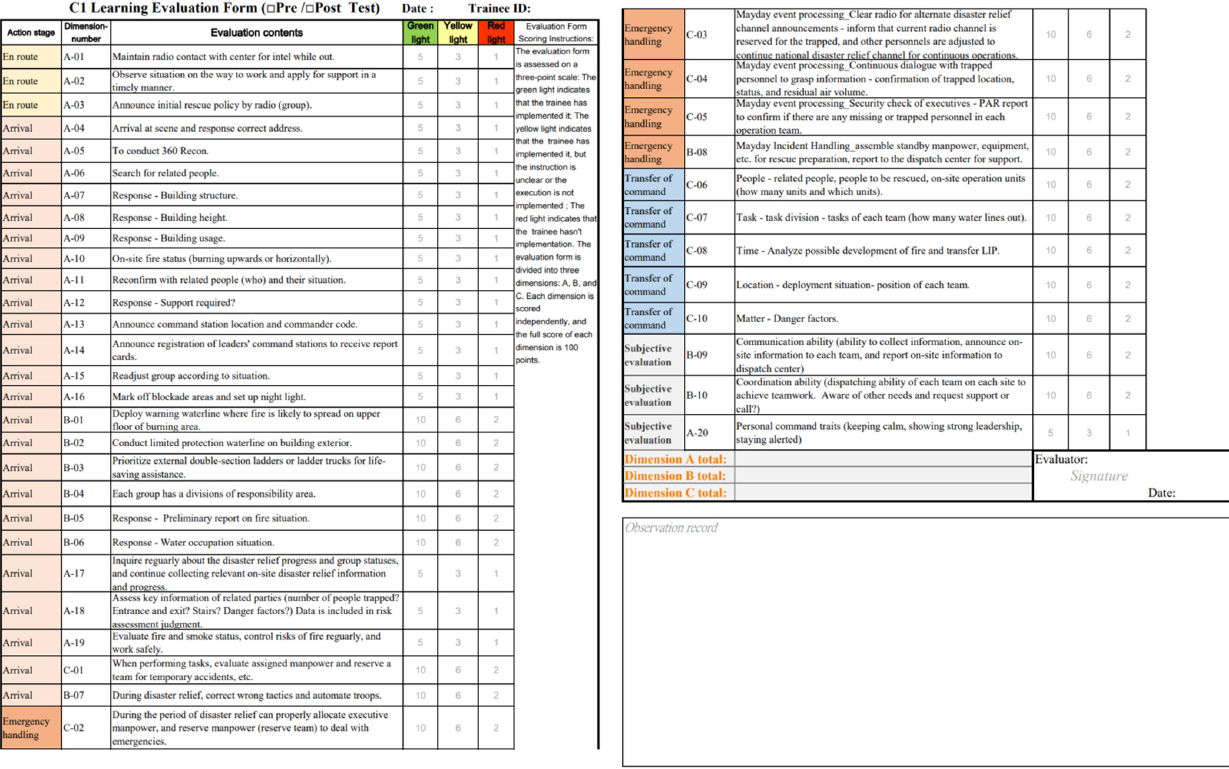
Figure A1. This Study’s Evaluation Form.